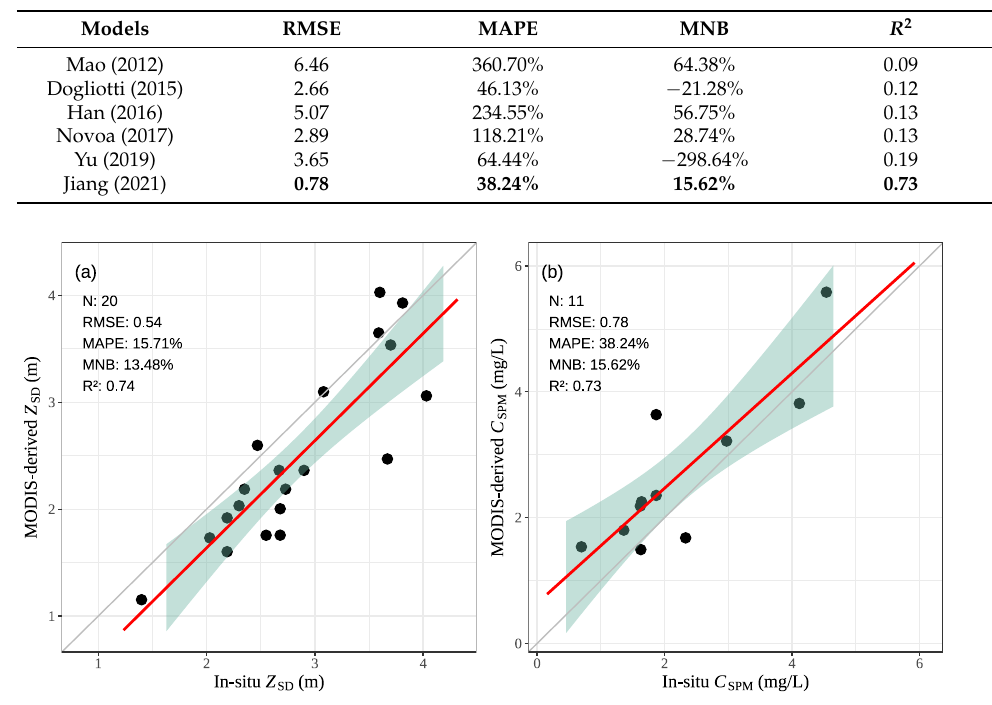
Figure 5. Comparison between the in situ measurements and MODIS-derived Z SD ( a ) and C SPM ( b ) with semi-analytical models (the red line is the regression line, and the translucent green indicates a 95% confidence